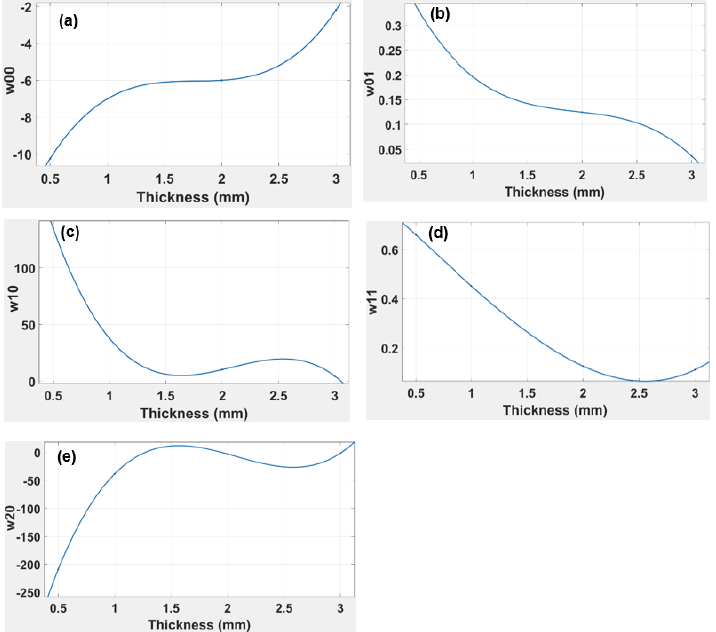
Figure 13. Graphs indicating the relationship of simple ABS beam thickness vs. correlation coefficient for ( a ) w00 ( b ) w01 ( c ) w10 ( d ) w11 and ( e ) w20.